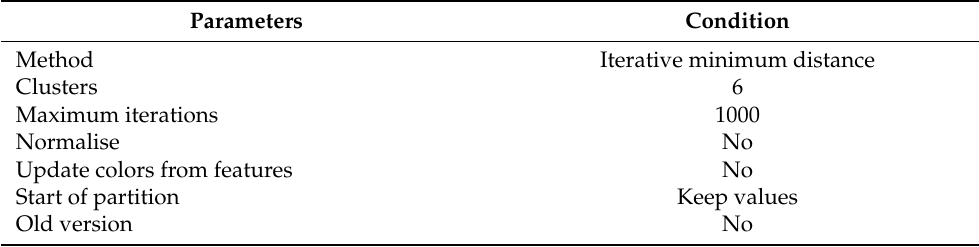
Table 1. Parameters used while running k-means clustering. Parameters Condition Method Iterative minimum distance Clusters